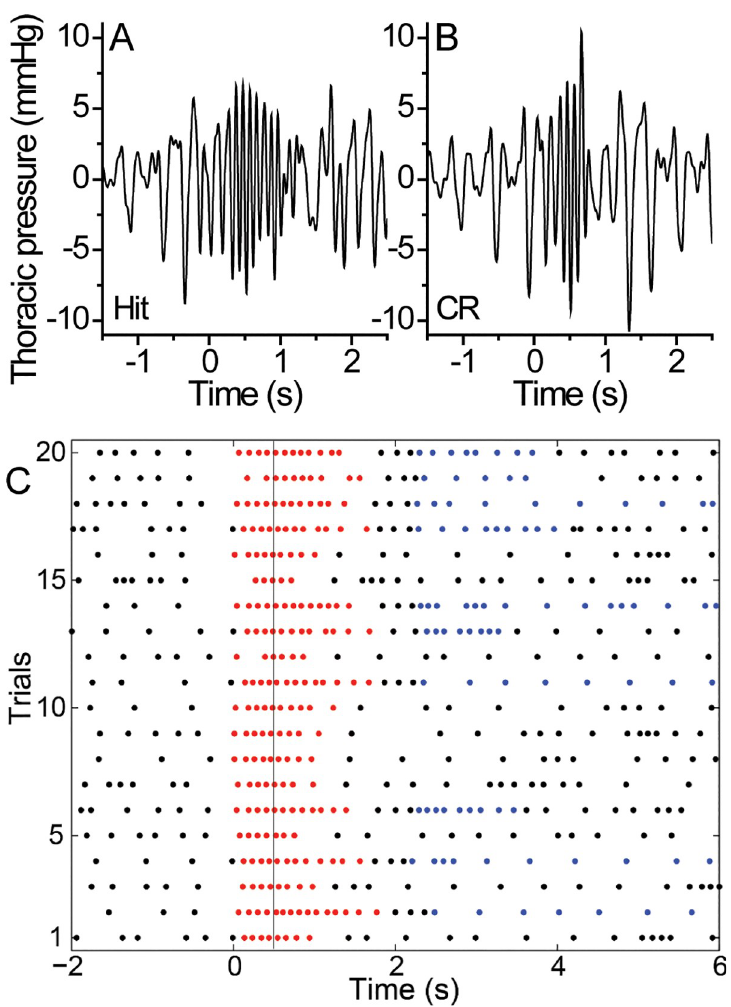
Fig 2. Recordings of thoracic pressure changes during odorant sampling. The breathing pattern during ( A ) Hit and ( B ) a correct rejection (CR) trial when exposed to 10 − 4 propanol concentration. Time 0 is the onset of the nose poke into the odor port. The odorant was delivered at 0.5 s. C Display of 20 trials of a 10 − 4 propanol concentration block. Each dot represents an inhalation, a red dot means the mouse’s nose is in the odor port, a blue dot means the mouse’s snout is in the water port and a black dot means that the mouse’s nose is in neither port. The grey line is the time of odorant delivery onset. Trials lacking blue dots (meaning the mouse did not enter the water port) are, for this chosen block, all CRs as no false alarms (FAs)